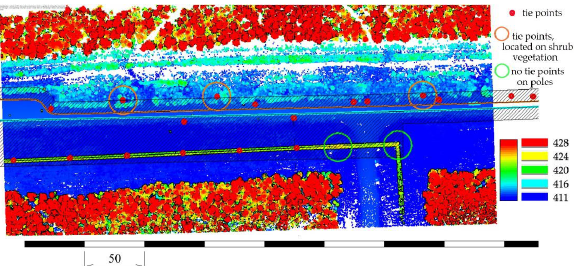
Figure 5 . An example of identified tie points on pole-like infrastructures and vegetation.